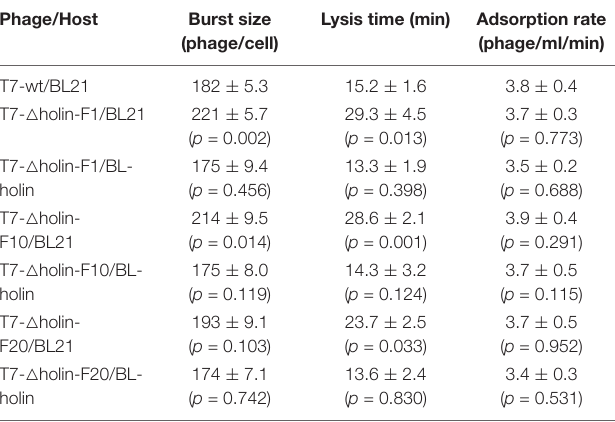
TABLE 1 | Phenotypic characterization of T7- (cid:52) holin phage infection of Escherichia coli BL21 cells. Phage/Host Burst size (phage/cell)